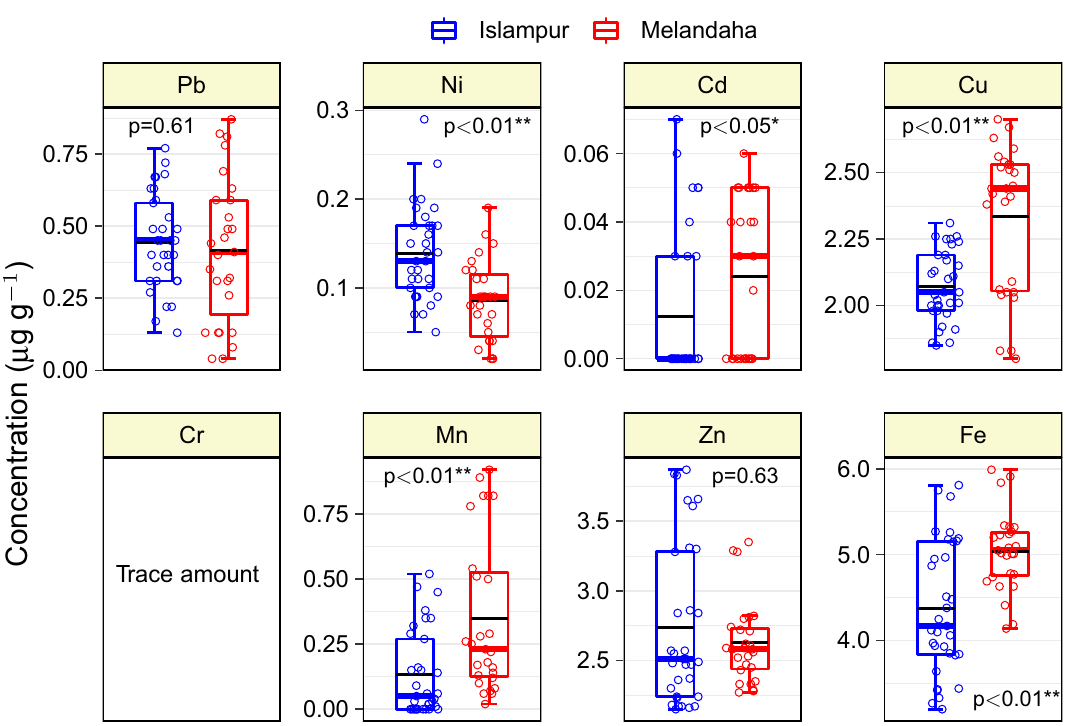
Figure 3. Trace elements concentration in brinjal fruits collected from different farmers ′ fields of Islampur and Melandaha Upazila of Jamalpur district, Bangladesh. Lower and upper box boundaries are 25th and 75th percentiles, respectively, whereas the colored (blue or red) horizontal line inside the box is median and the black line represents the mean value. The lower and upper error lines are 10th and 90th percentiles, respectively. Data points falling outside 10th and 90th percentiles are the outliers. The p-values are mean comparison (nonparametric Kruskal–Wallis test) of brinjal metal concentrations sampled from two study locations. Single and double asterisks associated with the p-values designate the means are different at 5% and 1% level of probability,